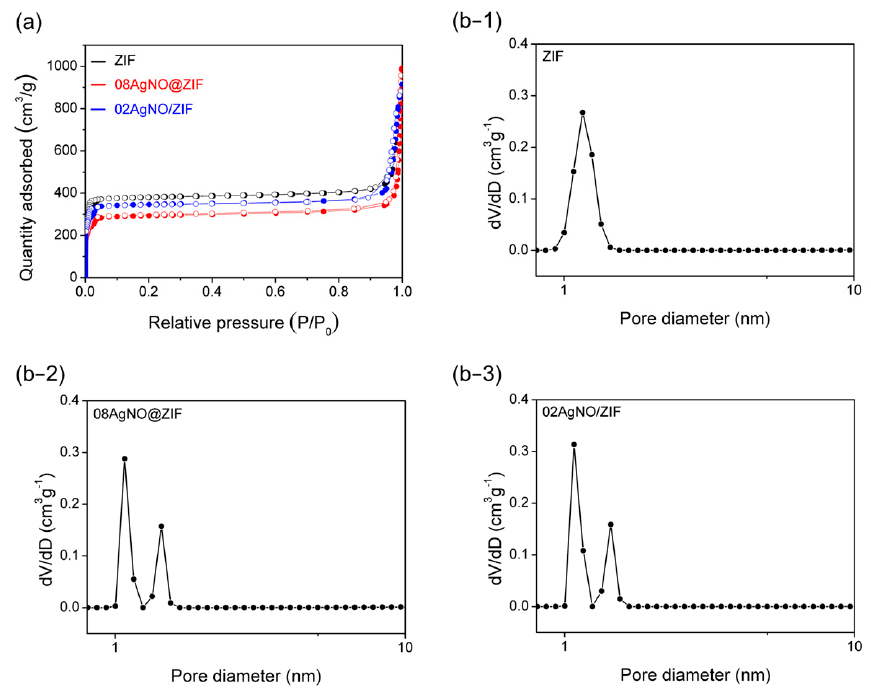
Figure 1. XRD diffraction patterns of ZIF-8 samples with de novo- synthesis (sample as ZIF-8, 04AgNO@ZIF, 08AgNO@ZIF) and impregnation method (sample as 01AgNO/ZIF, 02AgNO/ZIF) using AgNO 3 as the precursor. (a) ZIF-8, (b) 04AgNO@ZIF (de novo), (c) 08AgNO@ZIF (de novo), (d) 01AgNO/ZIF (impregnation), (e) 02AgNO/ZIF (impregnation).